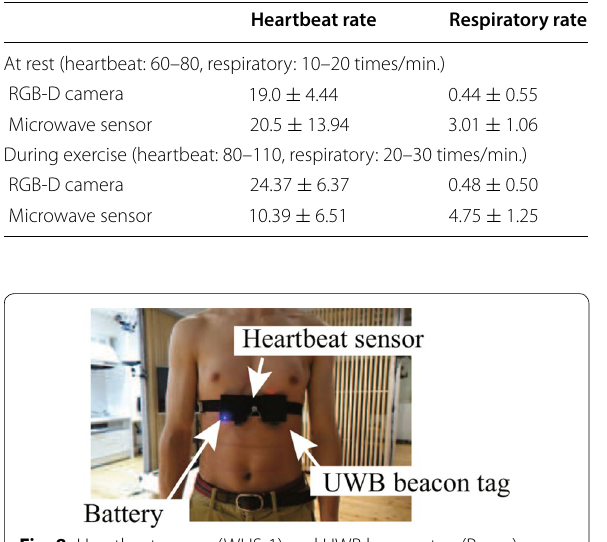
Table 1 Accuracy of vital data sensing (average